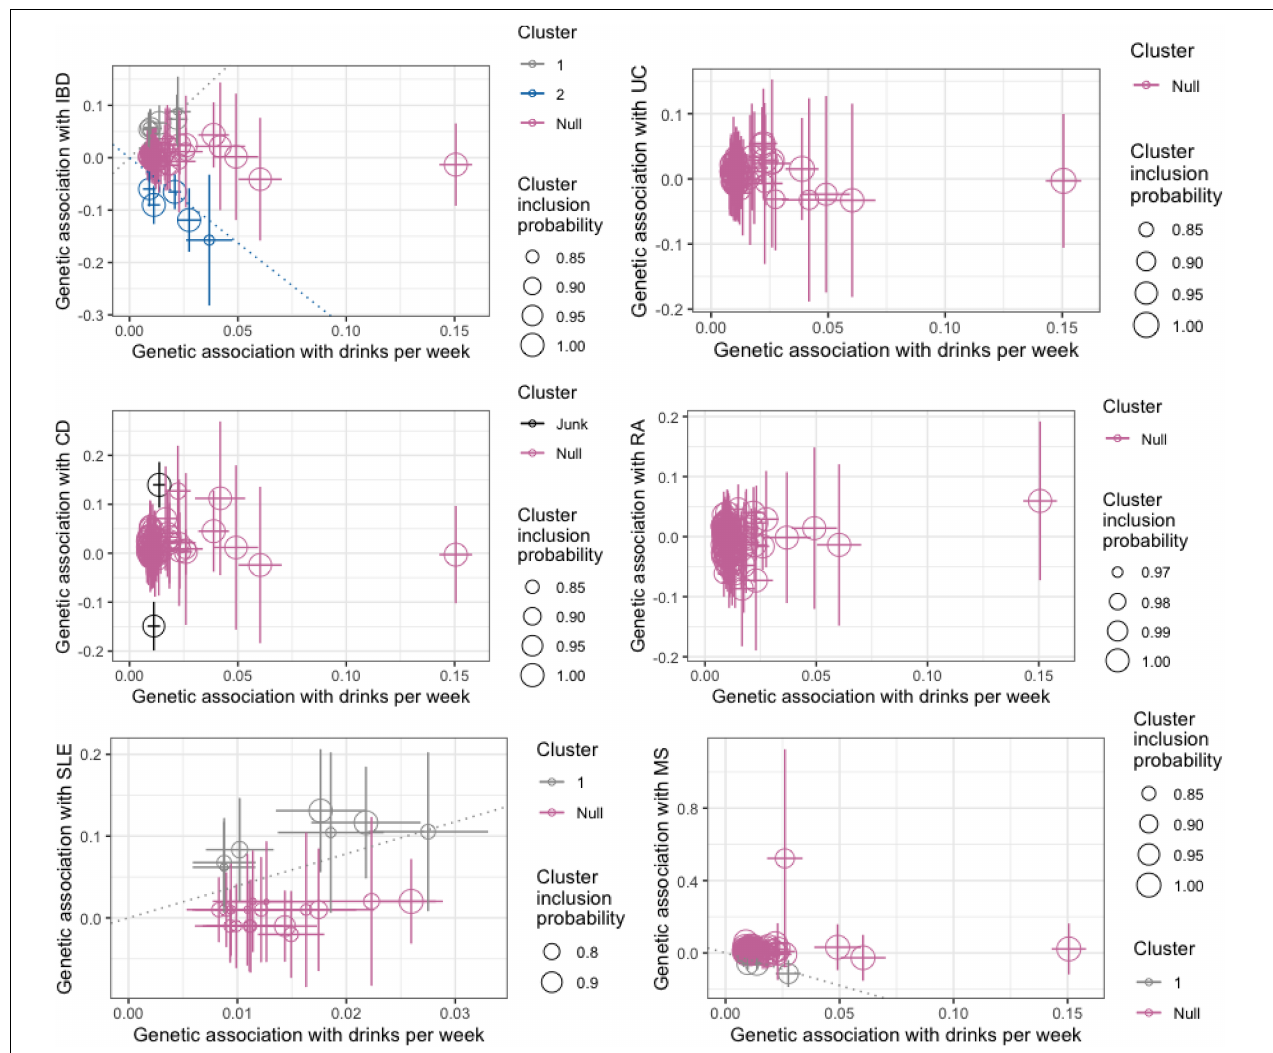
FIGURE 2 | Genetic associations with alcohol consumption (drinks per week) and risk of autoimmune inflammatory diseases (log odds) per additional alcohol consumption increasing alleles. Each genetic variant is represented by a point. Error bars are 95% confidence intervals for the genetic associations. Colors represent the clusters. Variants are only assigned to the cluster if the conditional probability is > 0.8 and cluster only displayed if at least four variants are assigned to the cluster. IBD, inflammatory bowel disease; UC, ulcerative colitis; CD, Crohn’s disease; RA, rheumatoid arthritis; SLE, systemic lupus erythematosus; MS, multiple